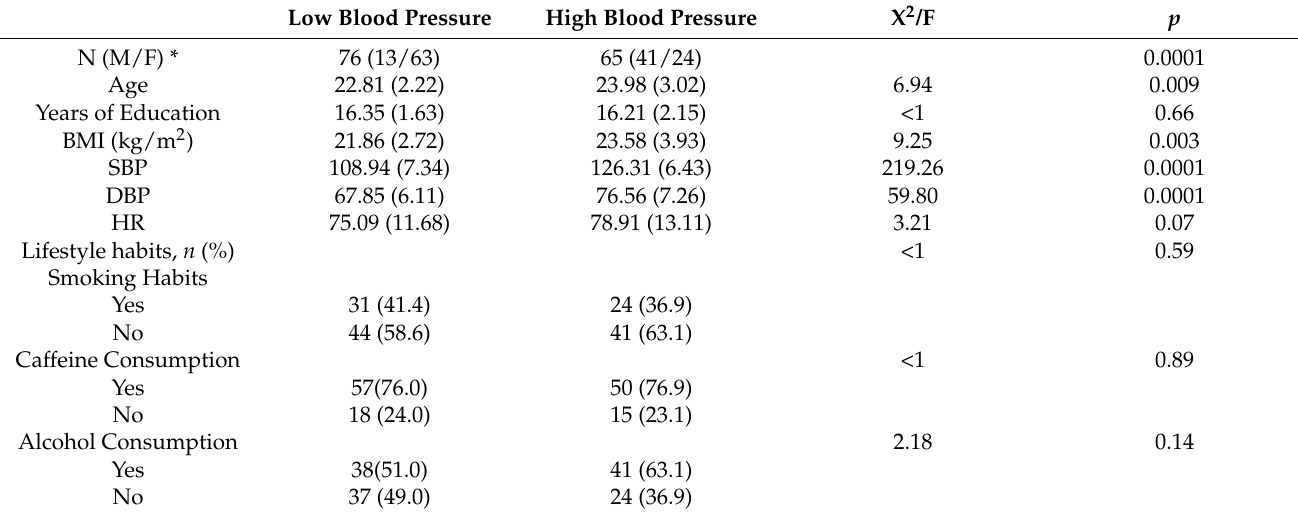
Table 2. Characteristics of the groups with high and low blood pressure.